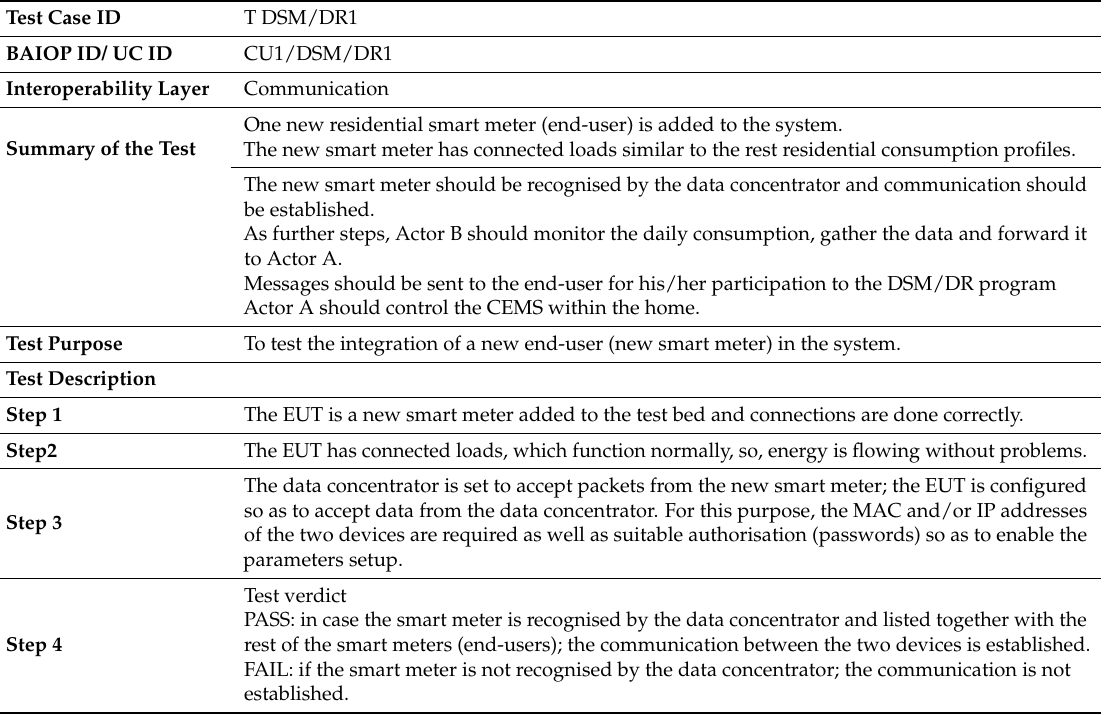
Table 10. BAIOP for the communication